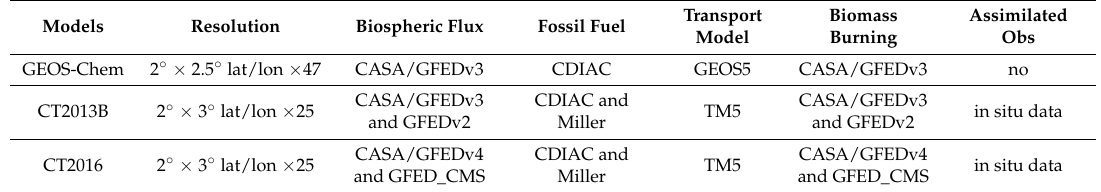
Table 1. Comparison of resolution, input surface CO 2 fluxes, transport models and assimilated observation Among CT2013B, CT2016 and